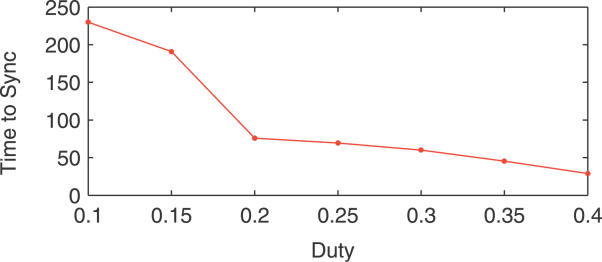
The Relationship between the Duty and the Time Required to Achieve Synchronization in the HH Neuron Model